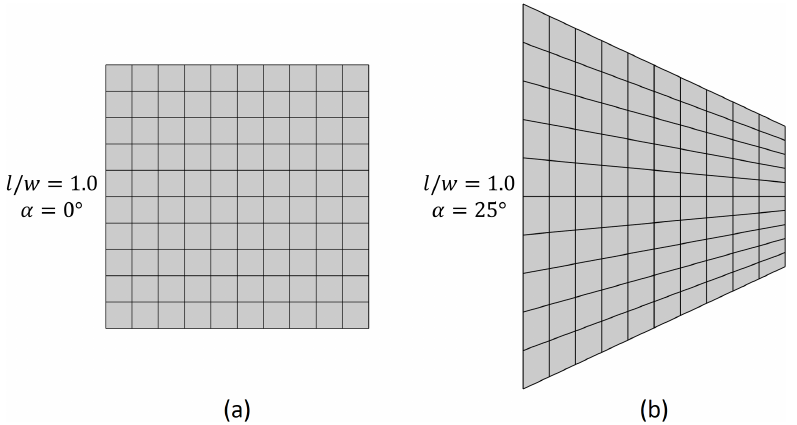
Figure 3. Exemplary finite element meshes for ( a ) non-tapered and ( b ) 25 ◦ width-tapered plates with l / w =